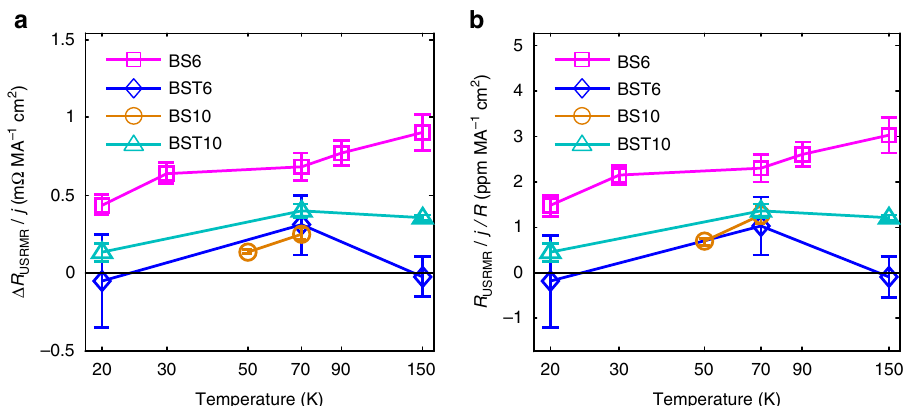
Fig. 5 Summary of USRMR. a Sheet USRMR per current density and b USRMR per current density per total resistance of all four samples at various temperatures. BS{ x } or BST{ x } are abbreviations of BS or BST samples of { x } QL thicknesses. The error bars indicate uncertainty bounds with 95% con fi dence. The uncertainties re fl ect the variations of observed signal level in the fi eld sweep and angle rotation data (see Supplementary Note 8